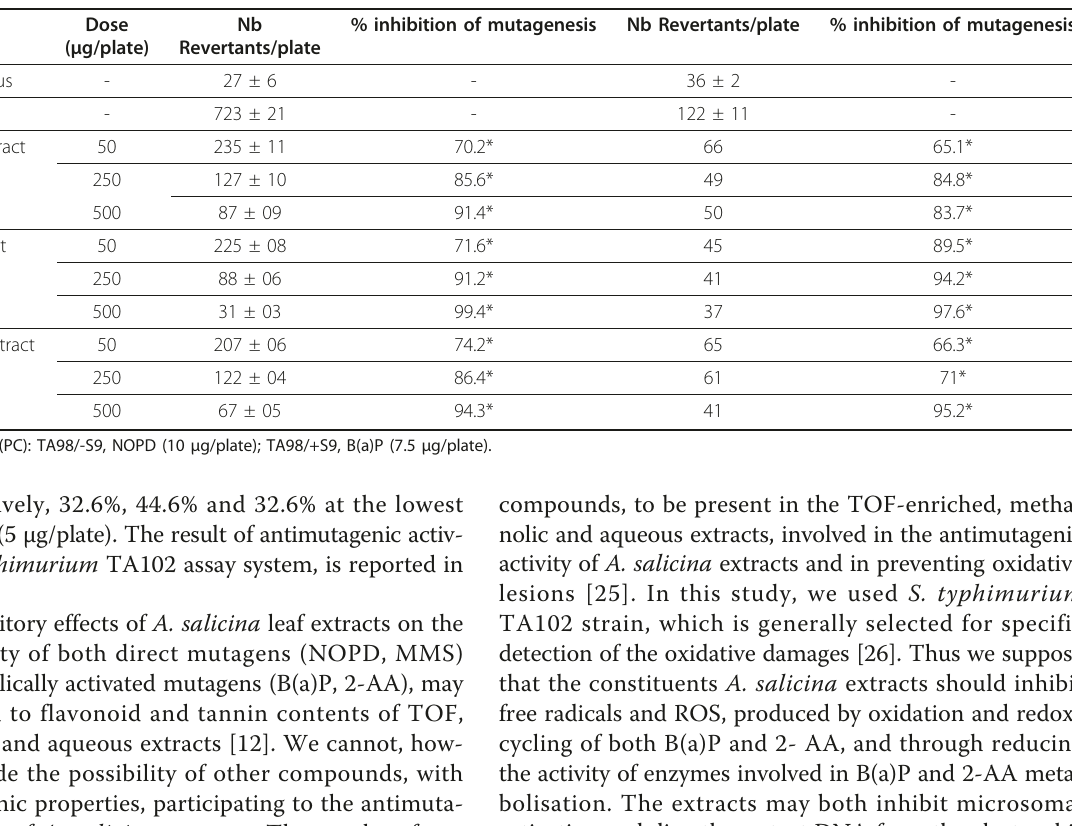
Table 3 Effects of extracts from A. salicina on the mutagenicity induced by NOPD (10 μ g/plate) and B(a)P (7.5 μ g/ plate) in S. typhimurium TA98 assay system respectively in the absence and in the presence of S9